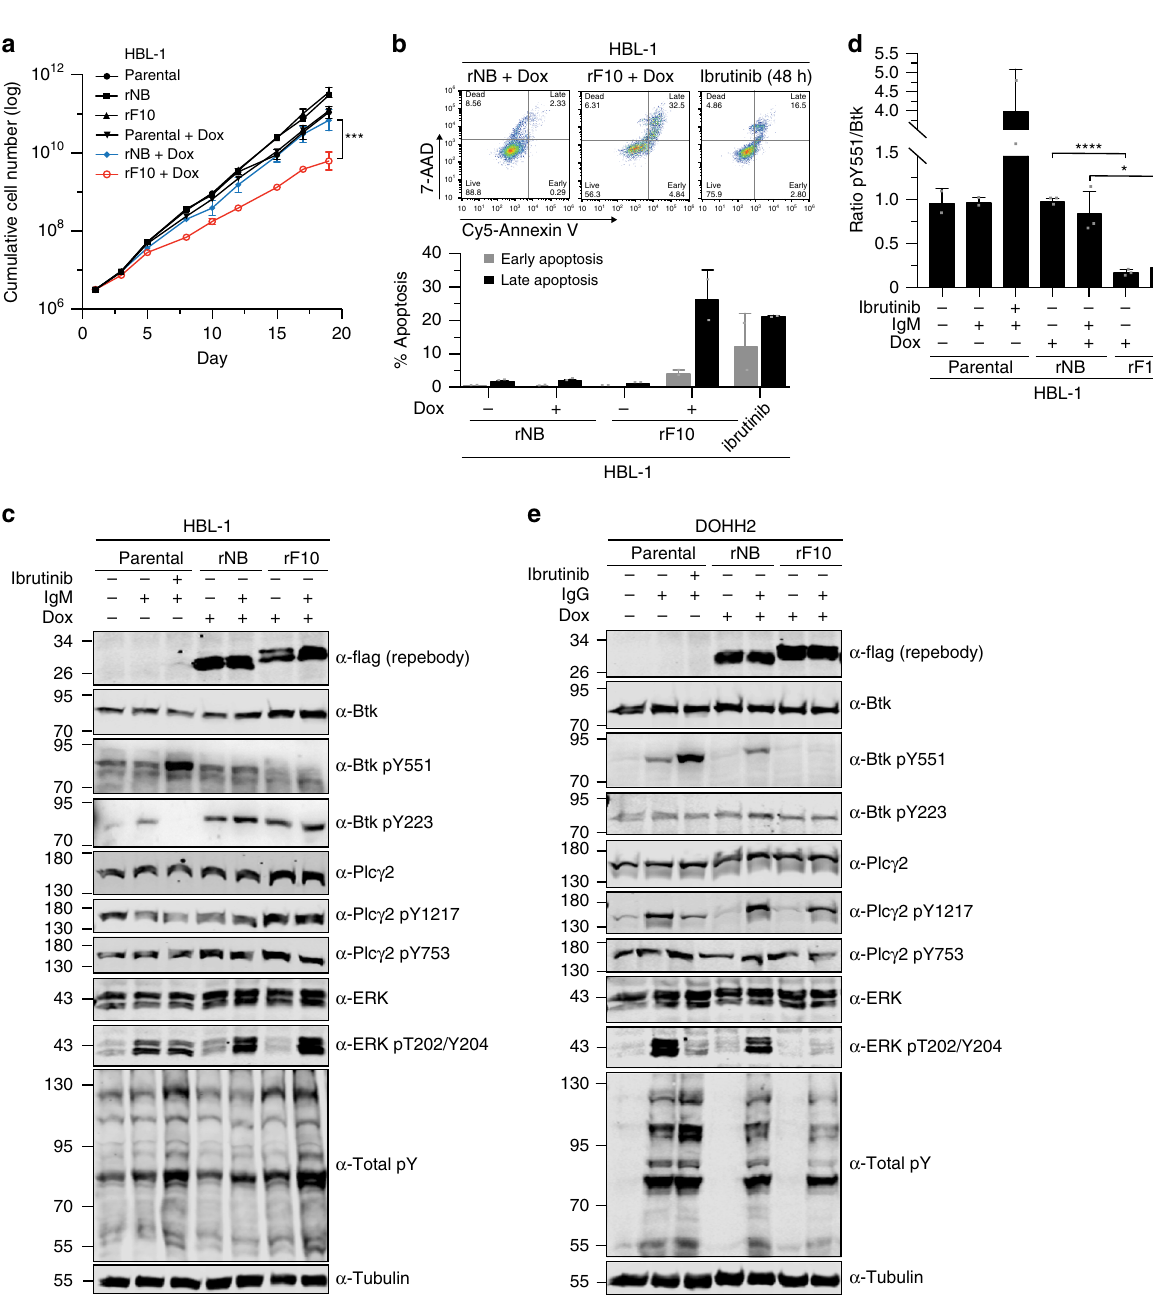
Fig. 7 Targeting the Btk SH2-KD interface decreases the viability of B-cell lymphoma cells and inhibits BCR signaling. a Cumulative cell number of HBL- 1 cells lentivirally transduced with a doxycycline-inducible system for expression of rF10 or rNB control repebodies ( n = 4). Parental cells are non- transduced cells. b Apoptosis analysis of transduced HBL-1 expressing the repebodies for 7 days. A representative gating of FACS staining is shown on top. The quanti fi cation of early (7AAD-/Annexin V + ) and late (7AAD + /Annexin V + ) apoptotic cells was obtained from two independent experiments ( n = 2). Parental HBL-1 cells treated with 10 µ M of ibrutinib for 48 h were used as positive control. c Immunoblot analysis from transduced HBL-1 cells expressing the repebodies (Flag-tagged) for 48 h. BCR signaling was stimulated with anti-human IgM or mock-treated for 2 min before cell lysis. Ibrutinib treatment (100 nM) was performed for 15 min prior to anti-IgM stimulation. Tubulin was used as loading control. d Quanti fi cation of Btk pY551 shown in c and normalized to total Btk expression. Data are mean ± SD from two biological replicates ( n = 3) and P -values were calculated using an unpaired t -test. * P ≤ 0.05. e Immunoblotting from transduced DOHH2 cells expressing the repebodies as performed in c . Source data are provided as a Source Data fi